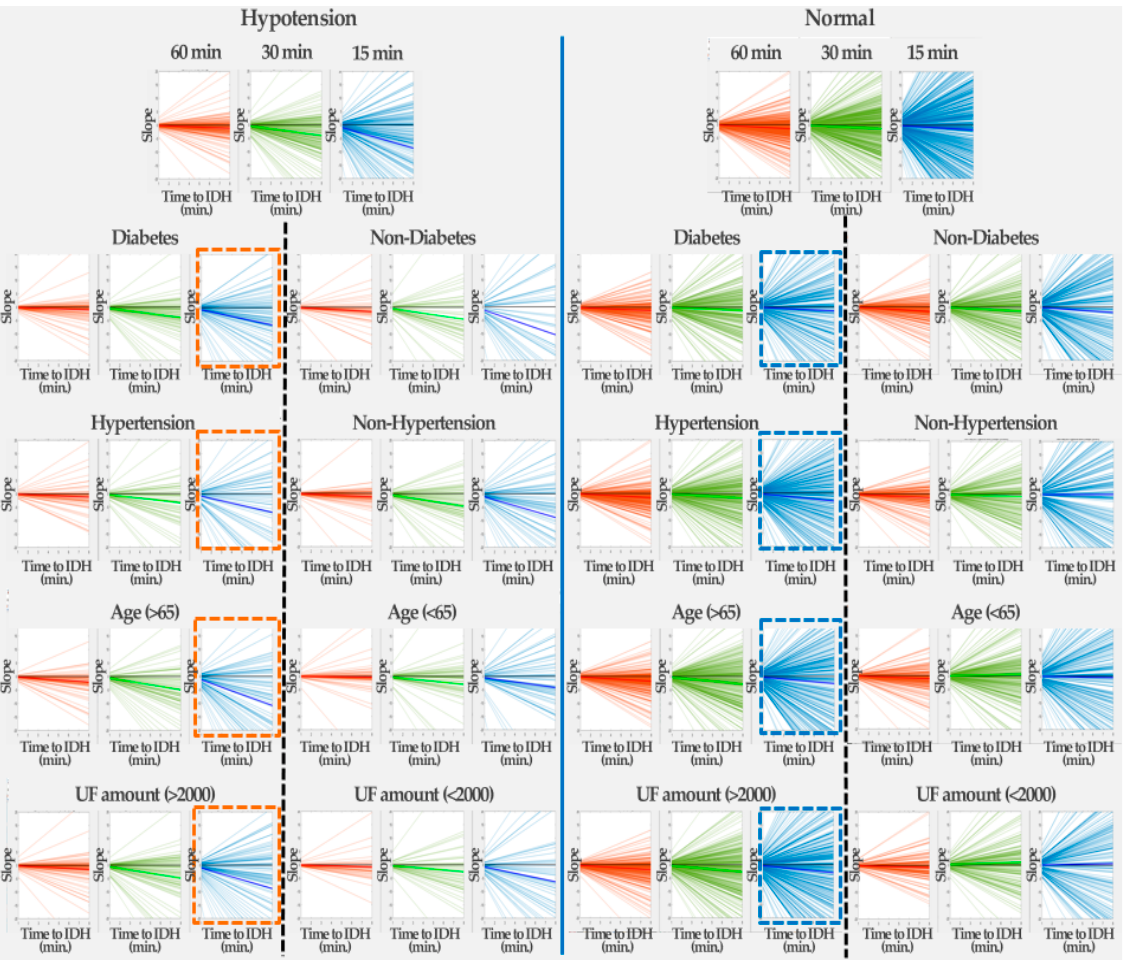
Figure 8. Changes in HR slope for IDH and normal (non-IDH) patients according to 30-min data by patient baseline information before the onset of IDH. (The dashed lines represent the lines separating the patient baseline information.)